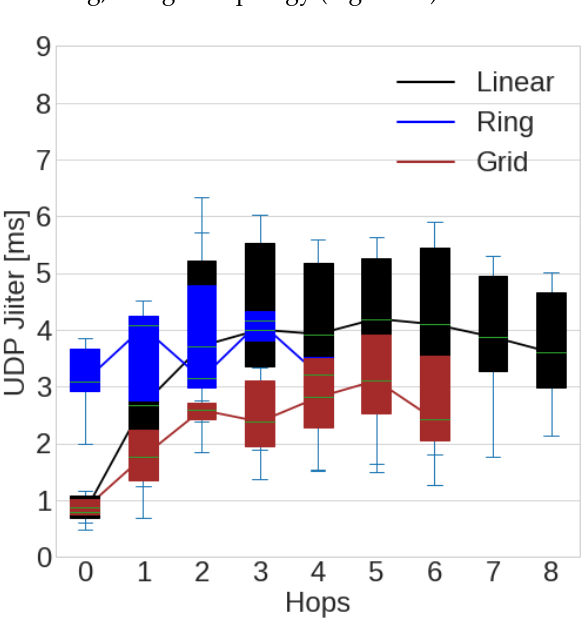
Figure 26. W-iLab2.t UDP